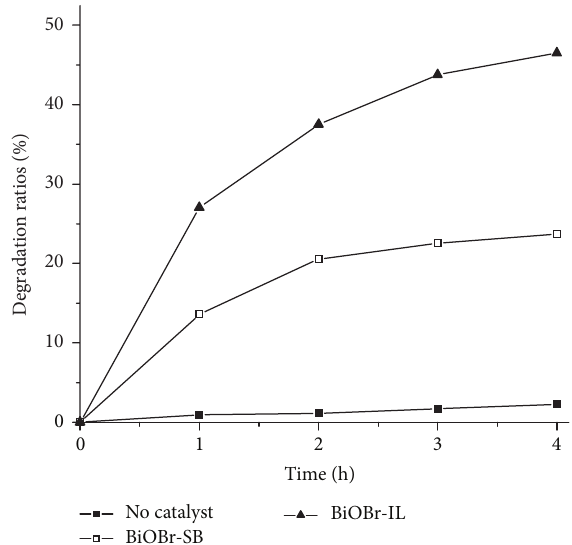
Figure 3: The plot of aniline degradation ratio versus reaction